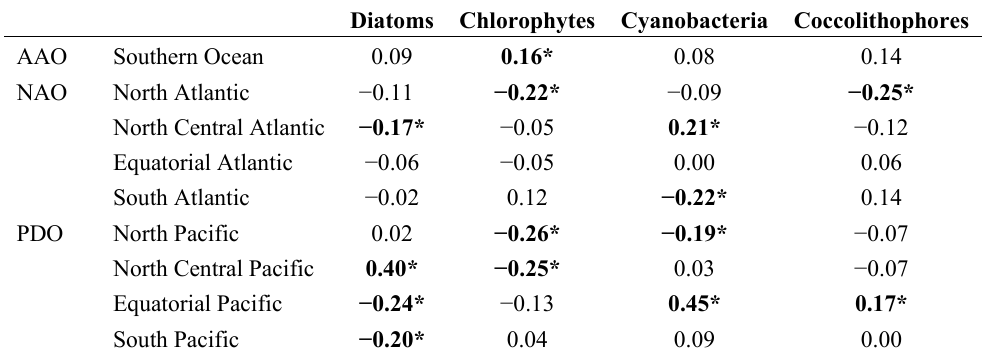
Table 3. Correlation coefficients between group-specific primary production and several region-specific climate indices: Antarctic Oscillation (AAO), North Atlantic Oscillation (NAO), and Pacific Decadal Oscillation (PDO). Bold and (*) indicates statistical significance ( p <